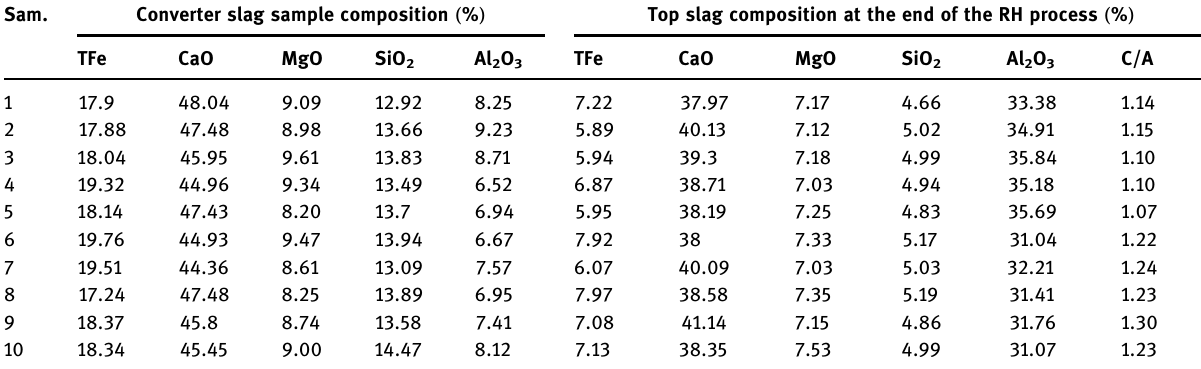
Sam. Converter slag sample composition ( % ) Top slag composition at the end of the RH process ( % )